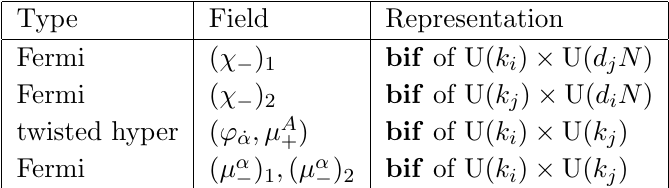
Table 2. Field contents of 2d gauge theories on